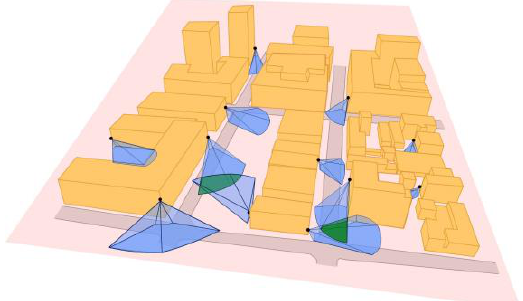
Figure 5 The FOV analysis of multiple CCTV